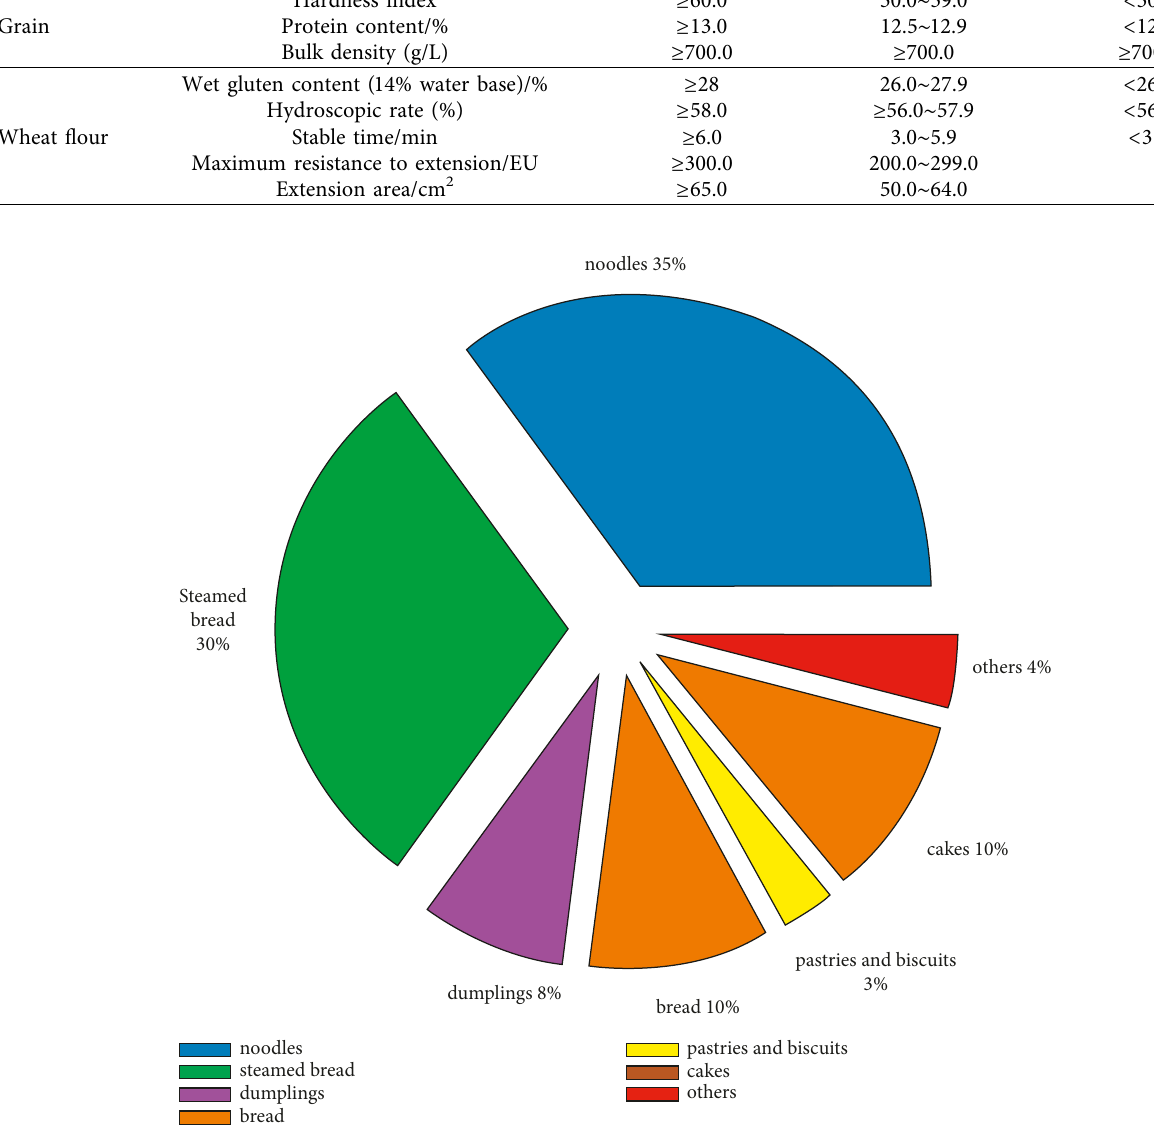
Figure 1: Proportion of pasta in flour